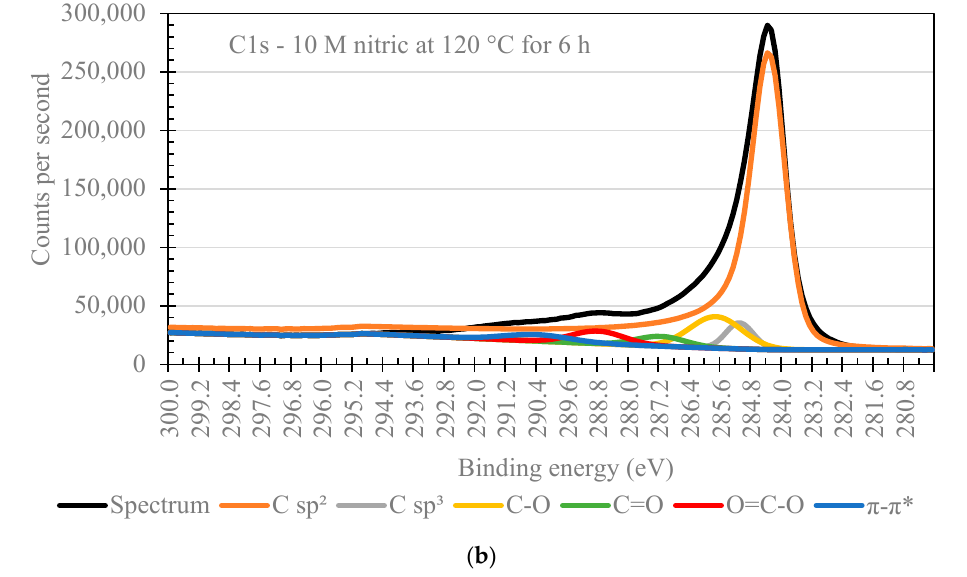
Figure 8. XPS C1s high resolution spectra results for ( a ) as-received and ( b ) acid treated (10 M nitric at 120 °C for 6 h) CNT.